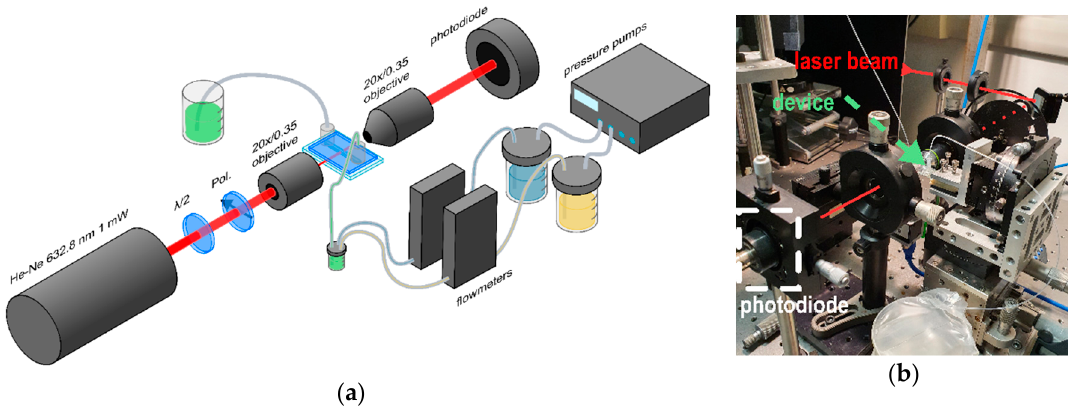
Figure 3. Opto-microfluidic setup allows controlling the flow of the liquid into the microchannel and the coupling of the laser beam in the waveguide. ( a ) Scheme of the setup used for the waveguide characterization and for the proof of concept experiment, in which the LN device is used as a pH meter. In the latter, two different solutions (blue and yellow in the scheme) presenting different pH values are independently flown and mixed into a common container. The resulting mixture (green) is driven into the microfluidic device. ( b ) Picture of the optical part of the experimental setup.